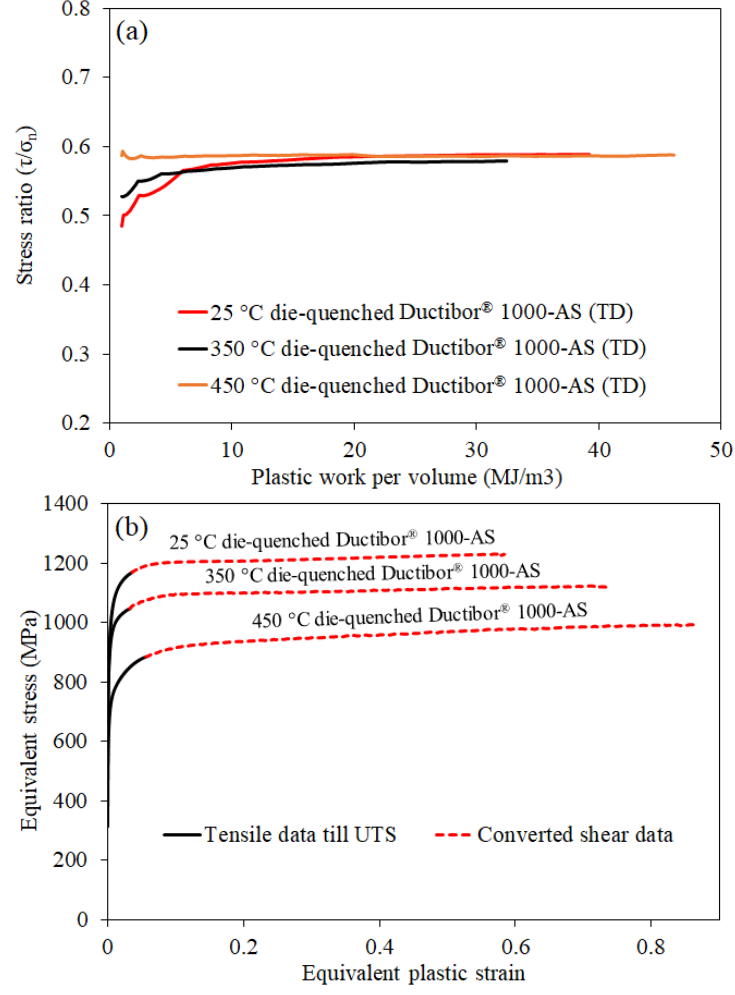
Figure 8. ( a ) The shear-to-tensile stress ratios vs. plastic work up to the UTS points and ( b ) the hard- ening curves extrapolated using the shear-conversion approach for various die-quenched conditions of Ductibor ® 1000-AS.